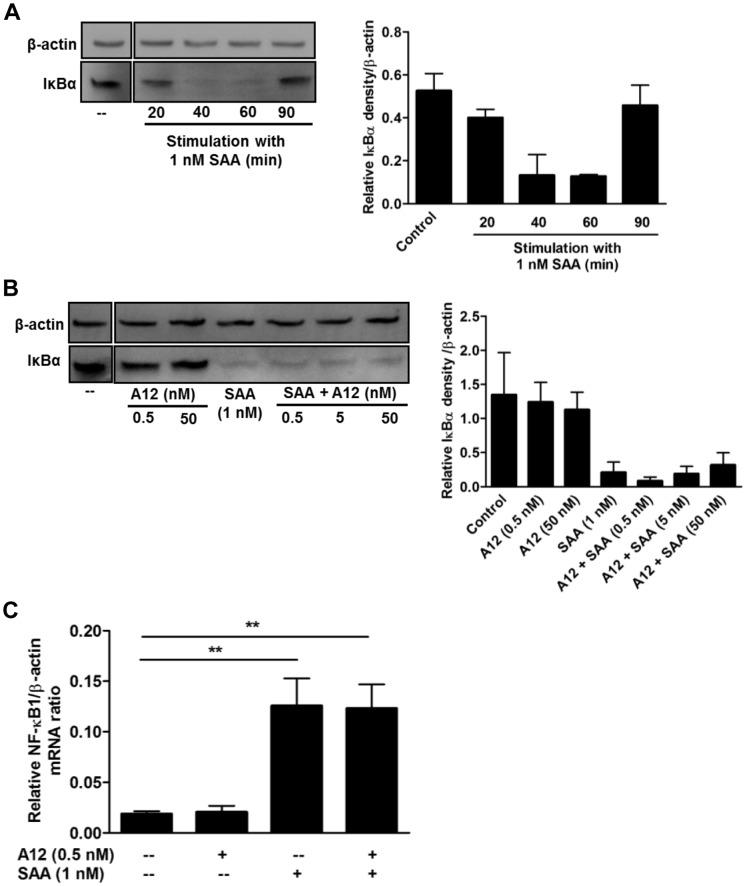
S100A12 did not alter SAA-induced IκBα degradation or NFκB1 gene expression.Western blots of cell lysates (30 µg total protein) with anti-IκBα Ab. (A) Time-course of SAA-induced IκBα degradation. THP-1 cells treated with SAA (1 nM) for 20–90 min. (B) THP-1 cells treated with S100A12 (0.5 nM or 50 nM), SAA (1 nM) or SAA (1 nM)+S100A12 (0.5 nM, 5 or 50 nM) for 40 min. Anti-β-actin Ab was used as a control for protein loading. Western blots in (A) and (B) were cropped to highlight relevant treatments for the study. (A and B, right panels) Intensities of bands corresponding to IκBα (39 kDa) were quantified by densitometry, and expressed as means ± SEM from two separate experiments. (C) THP-1 cells were treated with SAA (1 nM), S100A12 (0.5 nM) or SAA+S100A12 for 120 min, and NF-κB1 mRNA quantitated relative to β-actin mRNA; means ± SEM from four separate experiments; **p<0.01 compared to unstimulated control (analyzed by one-way ANOVA with Bonferroni’s correction for multiple comparison tests).